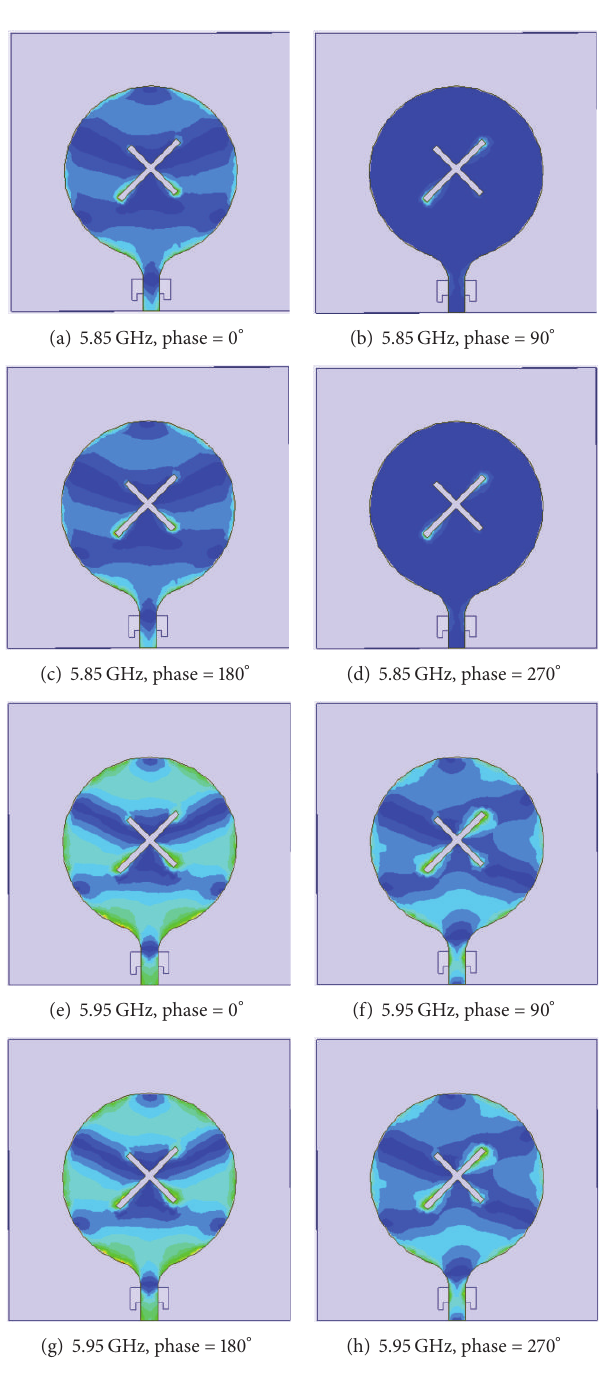
Figure 10: Current distribution at 5.85 and 5.95 GHz resonant frequencies for different